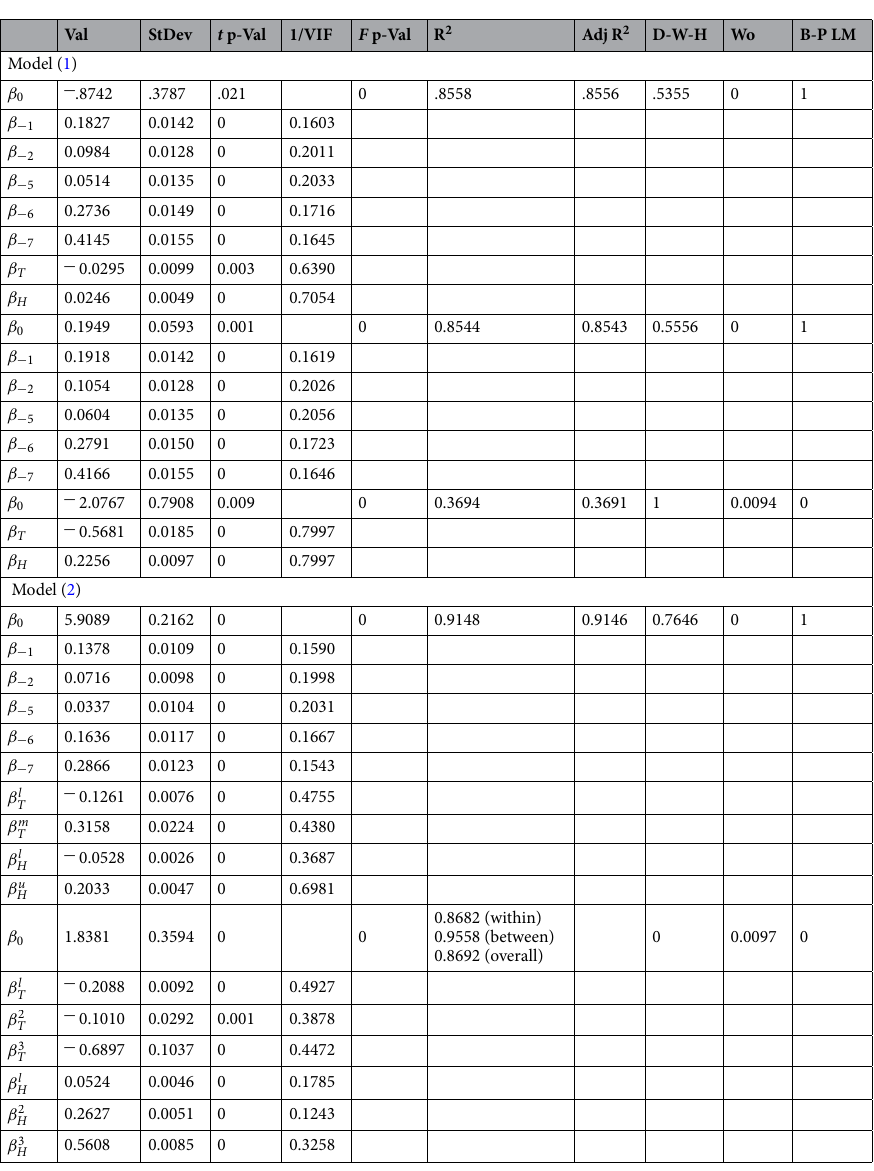
(Inverse Variance Inflation Factor for multicollinearity), F p-Val (p-value of the F -test for the overall variable 2 2 significance), R (coefficient of determination), Adj R (adjusted coefficient of determination), D–W–H (p-value of Durbin–Wu–Hausman test for random-effects vs. fixed-effects estimator), Wo (p-value of Wooldridge test for the serial correlation), B–P LM (p-value of Breusch–Pagan test for random effect vs pooled